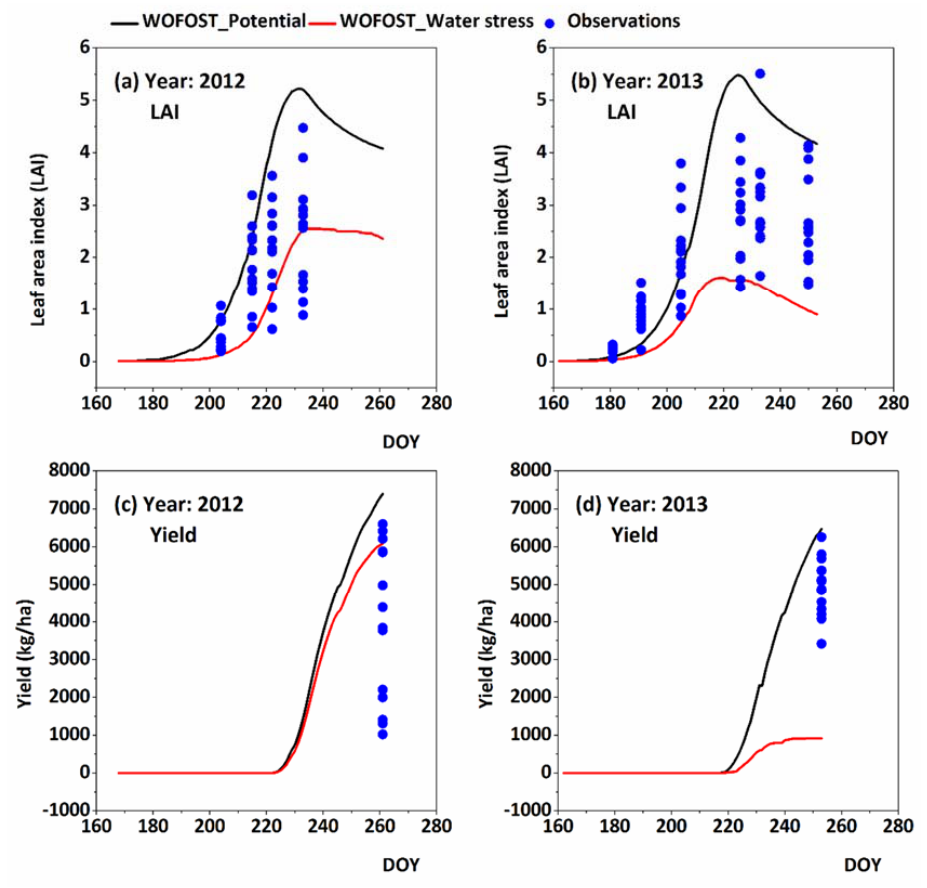
Figure 3. Simulated and observed leaf area index (LAI, a , b ) and yield ( c , d ) in 2012 and 2013. Black lines indicate potential simulations using calibrated potential crop parameters. Red lines indicate the water ‐ stressed condition, activated using the water stress function in WOFOST. Blue dots represent observations.